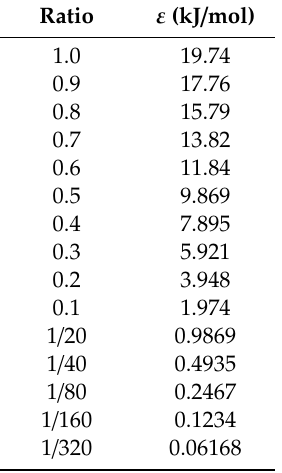
Table 1. The parameters of ε in the calculation. The ε = 19.74 kJ / mol is the case of copper. Ratio ε (kJ / mol)